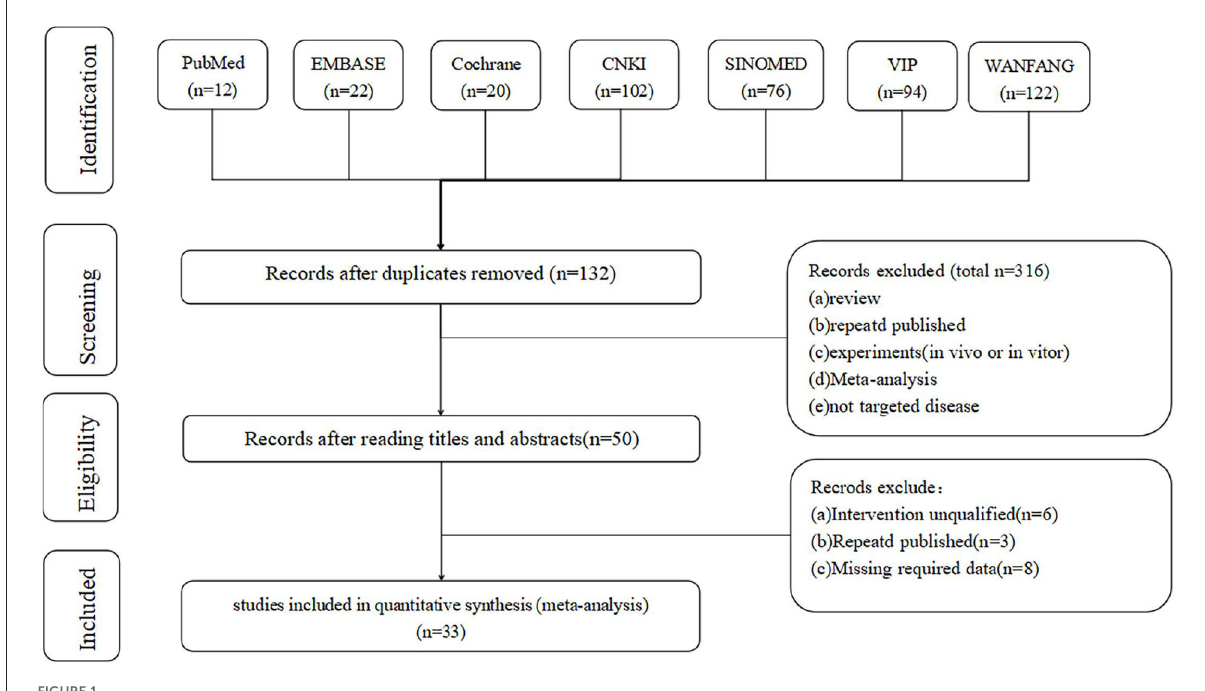
FIGURE1 Detailed process flowchart of the study